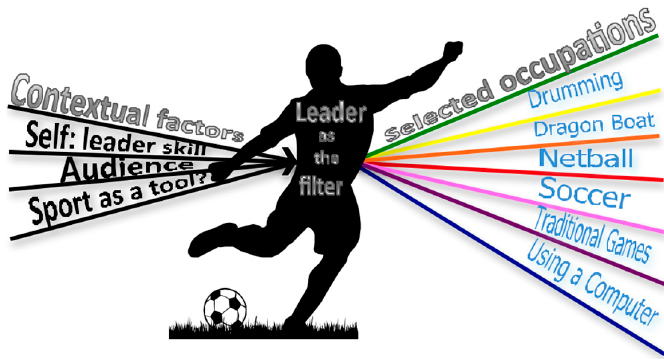
Figure 1. Leader as the filter.